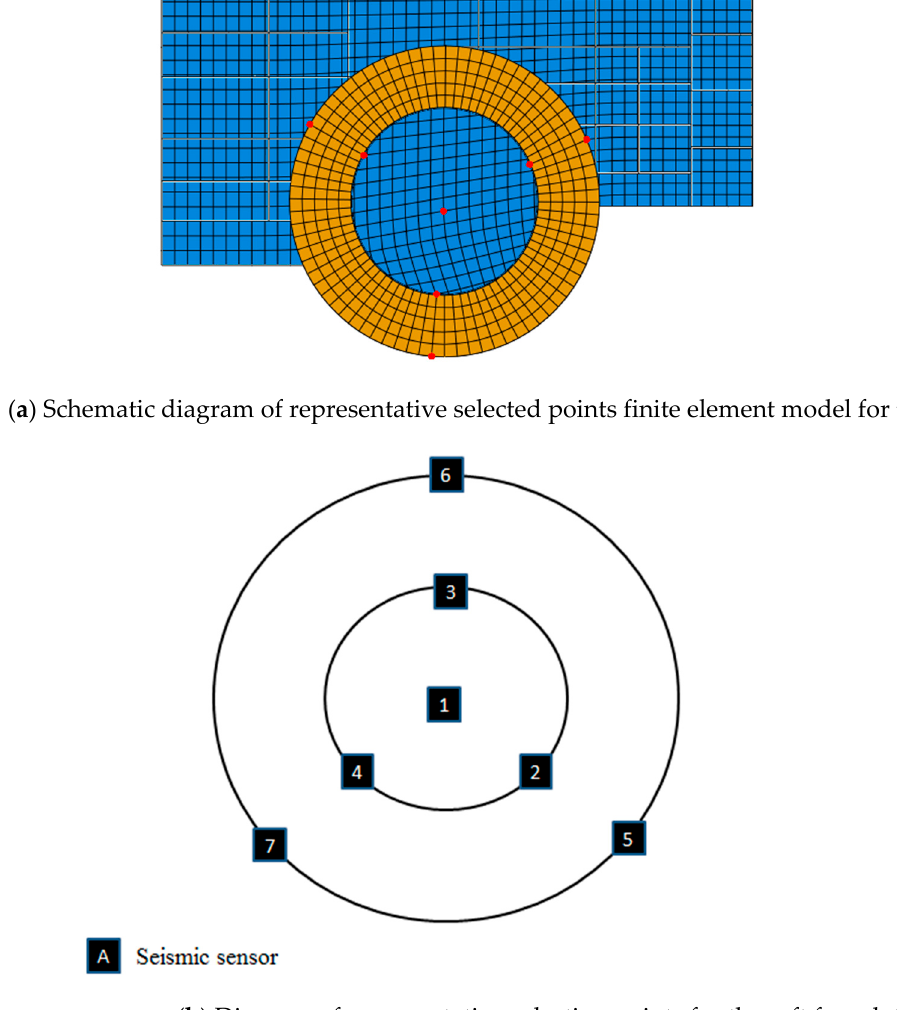
Figure 7. Schematic diagram of representative point selection of the raft foundation.